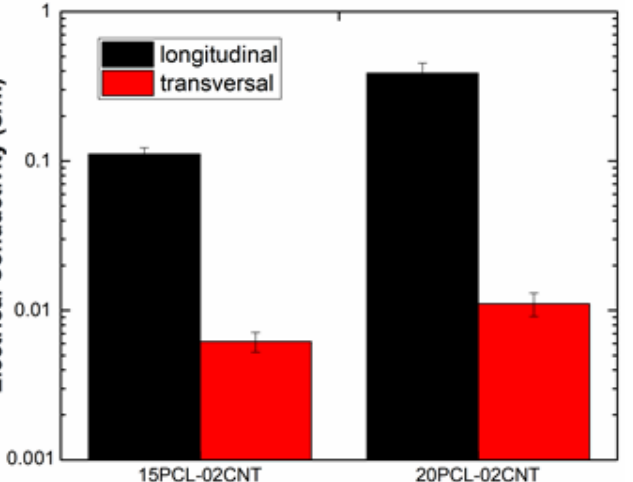
Figure 5. Electrical conductivity values of the PCL/CNT GFRP samples in the longitudinal and transverse direction.